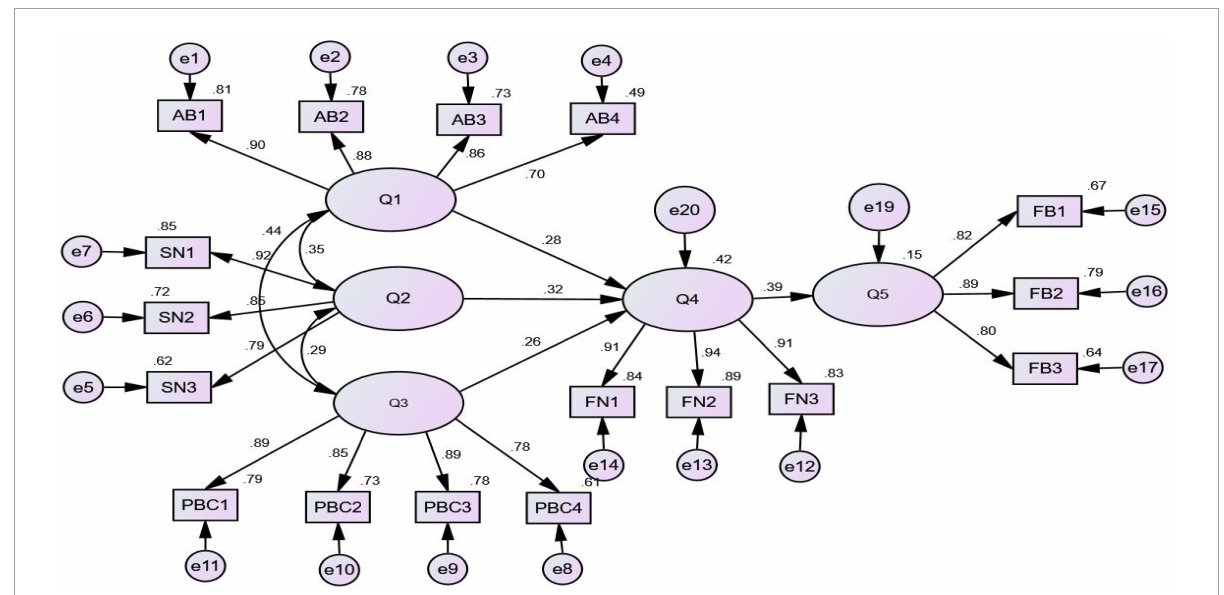
FIGURE2 Path coefficient diagram about the influence of large professional households on FN and FB of green agricultural